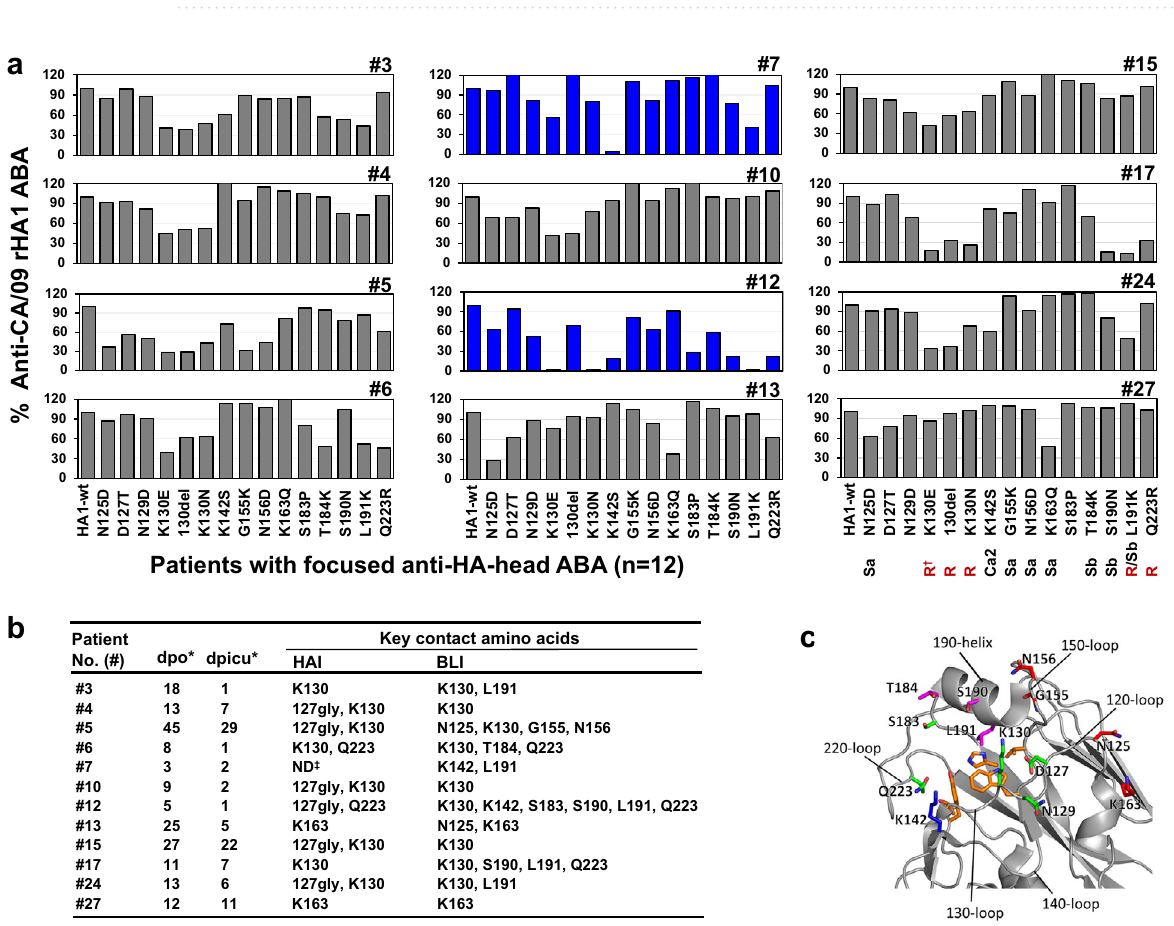
Figure 3. Determination of immunodominance of anti-HA-head binding antibody responses and epitope mapping. Anti-HA-head ABAs were determined by BLI assays using a rHA1-wt (HA-head from CA/09) and 15 rHA1-mutants possessing single point mutations or a K130 deletion (130del). ( a ) The 12 patients displayed focused anti-head ABA [defined by > 50% ABA reduction against rHA1-mutant(s) compared to rHA1-wt]. Patients #7 and #12 showing completely focused ABA are highlighted in blue. ( b ) Summary of key contact aa determined by HAI assays and BLI assays. Key contact aa are determined as virus-mutants or rHA1-mutants causing ≥ fourfold HAI antibody reduction in HAI assays or > 50% ABA reduction in BLI assays, respectively. ( c ) Key contact residues are mapped onto the CA/09 HA-head structure monomer. Antigenic sites Sa (red), Sb (Magenta), Ca (Blue), Receptor binding site (RBS, orange). *Serum collection days post-symptom onset (dpo) and post ICU admission (dpicu). † R, RBS. ‡ ND, not